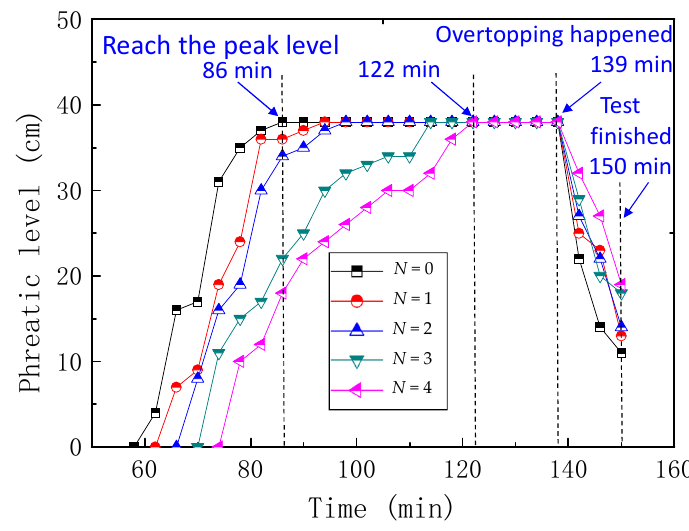
Figure 7. Phreatic level of JR-02 during test.